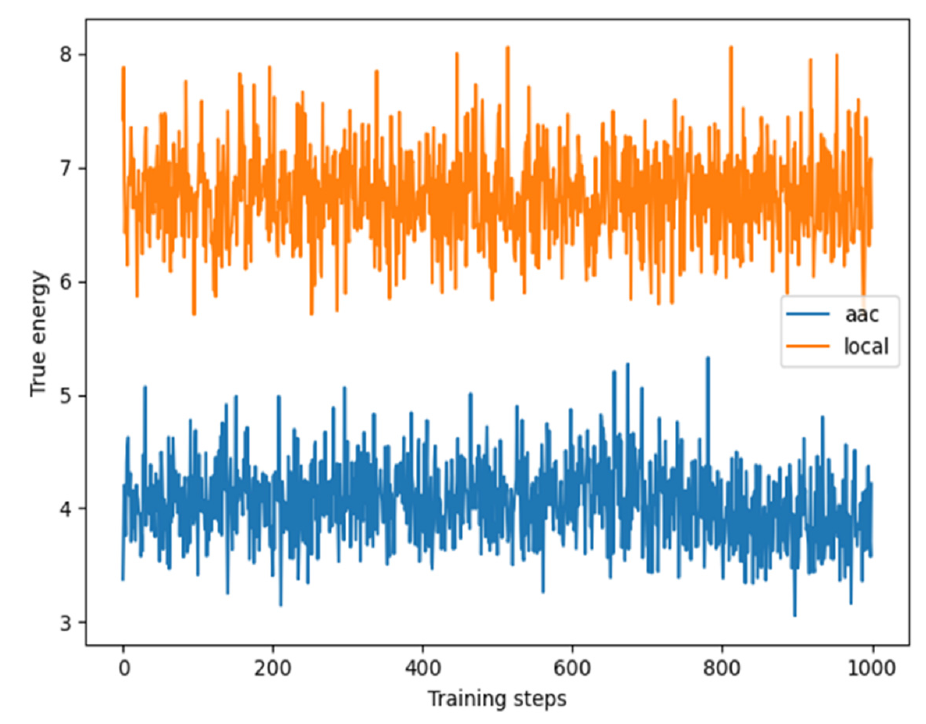
Figure 7. Total system energy consumption based on improved AAC multi-leakage real-time detec- tion algorithm with fully locally calculated system.